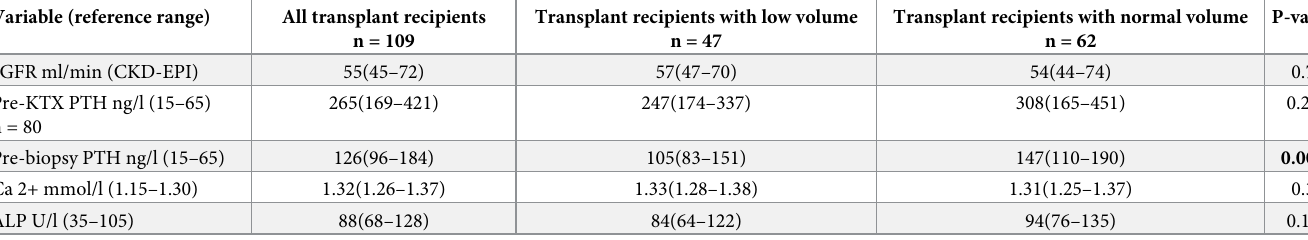
Values are expressed as median + interquartile range (in parentheses). eGFR, glomerular filtration rate; CKD-EPI, Chronic Kidney Disease Epidemiology Collaboration; KTX, kidney transplantation; PTH, parathyroid hormone; Ca2+, ionized calcium; ALP, alkaline